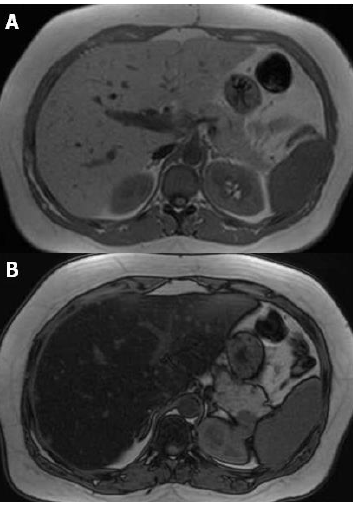
Figure 3. MR T1-weighted images with different echo times (TE) 4.2 ( A ) and 2.1 ( B ), show a marked drop of signal intensity in the out-of-phase image ( B ) which is a sign of severe steatosis.